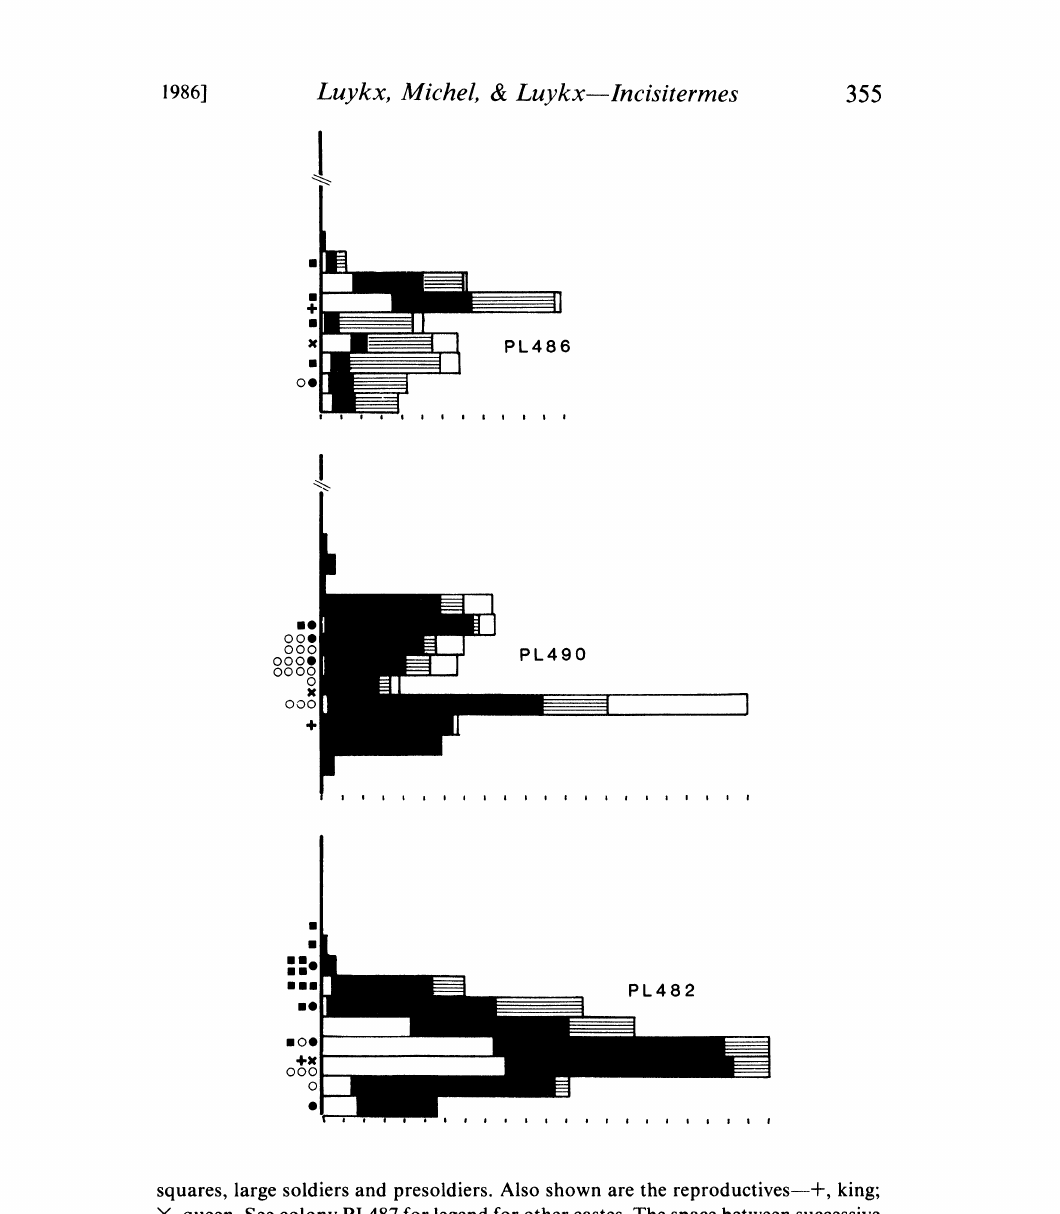
squares, large soldiers and presoldiers. Also shown are the reproductives--/, king; )<, queen. See colony PL487 for legend for other castes. The space between successive tick-marks at the bottom of each colony represents ten individuals. Note that the scales for Figs. A and B are